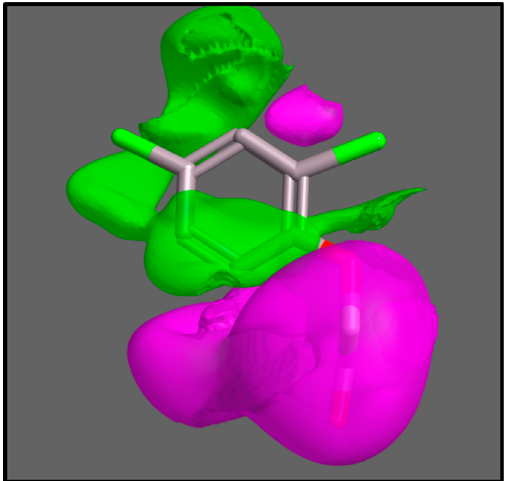
Figure 3. The AUX1 pharmacophore. The pharmacophore is a three-dimensional map of the characteristics of all known substrates of AUX1 [44]. The activity cliff map for hydrophobicity is shown with the structure of 2,4-D inside as a reference compound. The volumes coloured green indicate spaces where additional hydrophobicity increases activity (compounds filling these spaces with hydrophobic groups are better substrates for AUX1); the volumes coloured magenta indicate spaces where hydrophobicity decreases activity.